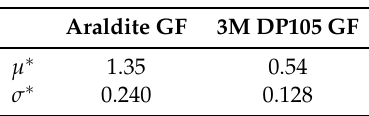
Table 1. Apparent gage factor summary for Araldite and 3M DP105 adhesives ( µ ∗ = mean, σ ∗ = standard